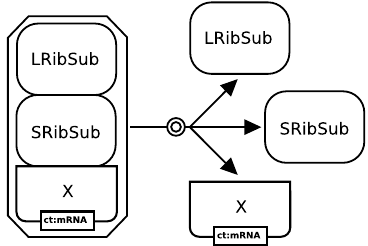
Figure 2.39: Dissociation of the small and large ribosomal subunits from a messenger